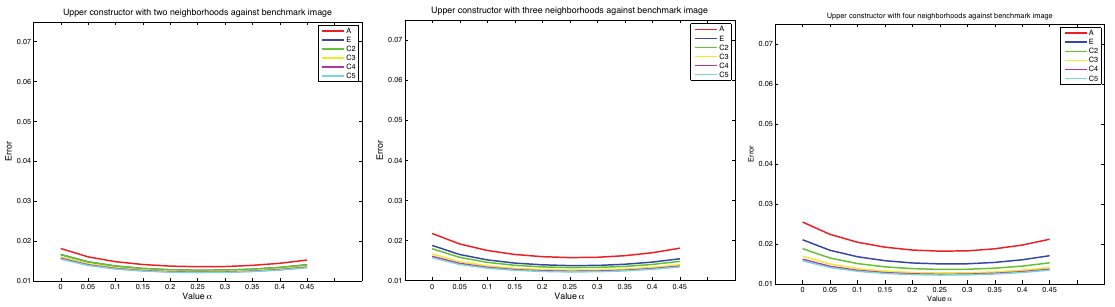
Figure 6: Performance of the upper constructor when 2 (left), 3 (middle) or 4 (right) neighborhoods are consid- ered.